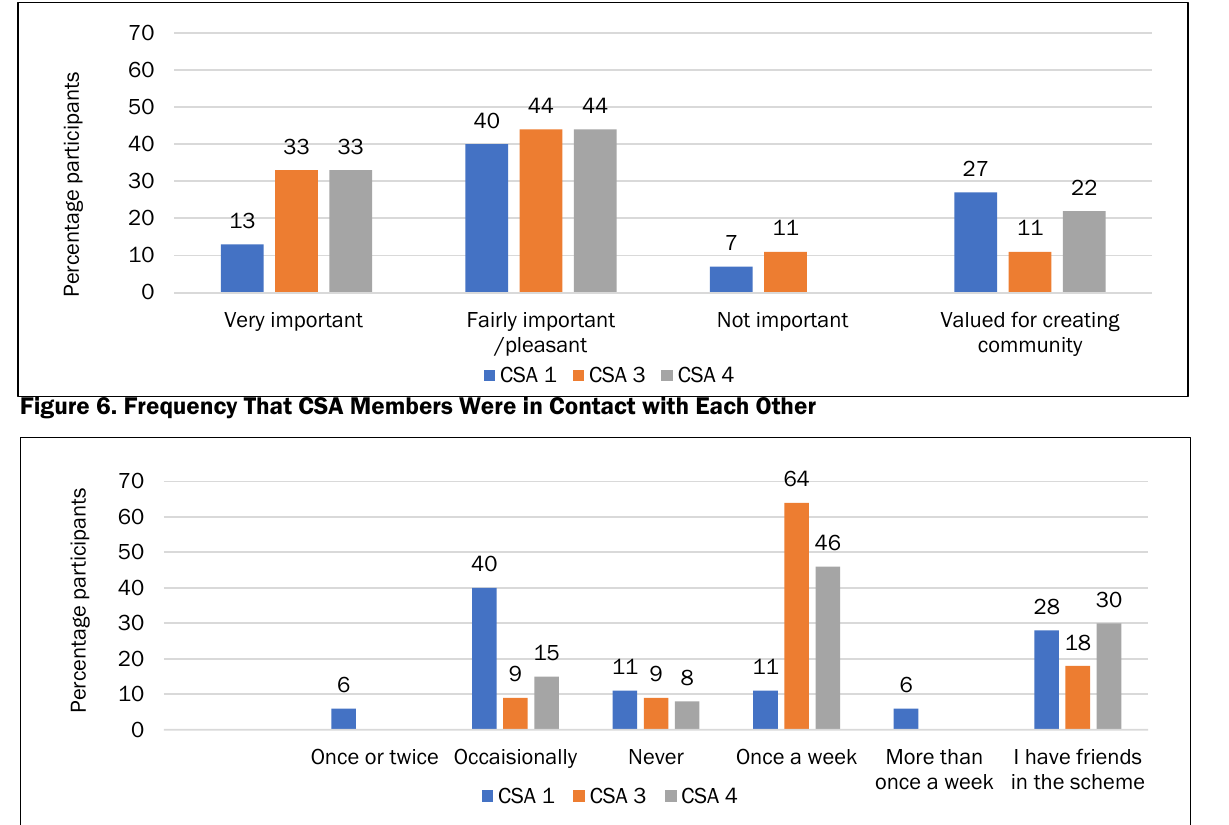
Figure 5 . CSA Members’ Evaluations of the Importance of Their Interactions with Other